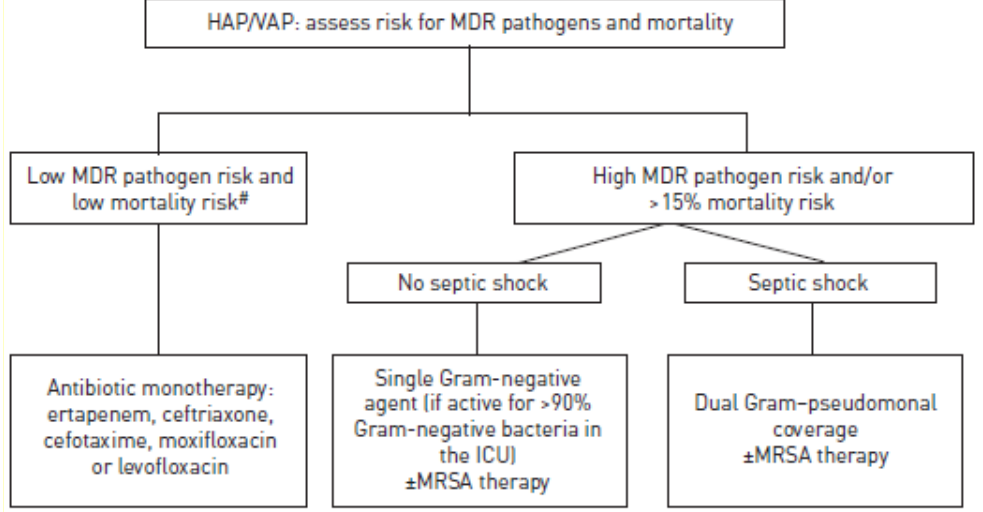
Figure 1. Empiric antibiotic treatment algorithm for hospital-acquired pneumonia [HAP]/ventilator- associated pneumonia [VAP]. MDR: multidrug-resistant, ICU: intensive care unit, MRSA: methicillin- resistant Staphylococcus aureus. # : Low risk for mortality is defined as a <15% chance of dying, a mortality rate that has been associated with better outcome using monotherapy than combination therapy when treating serious infections (Kumar A et al., 2010). Reproduced from